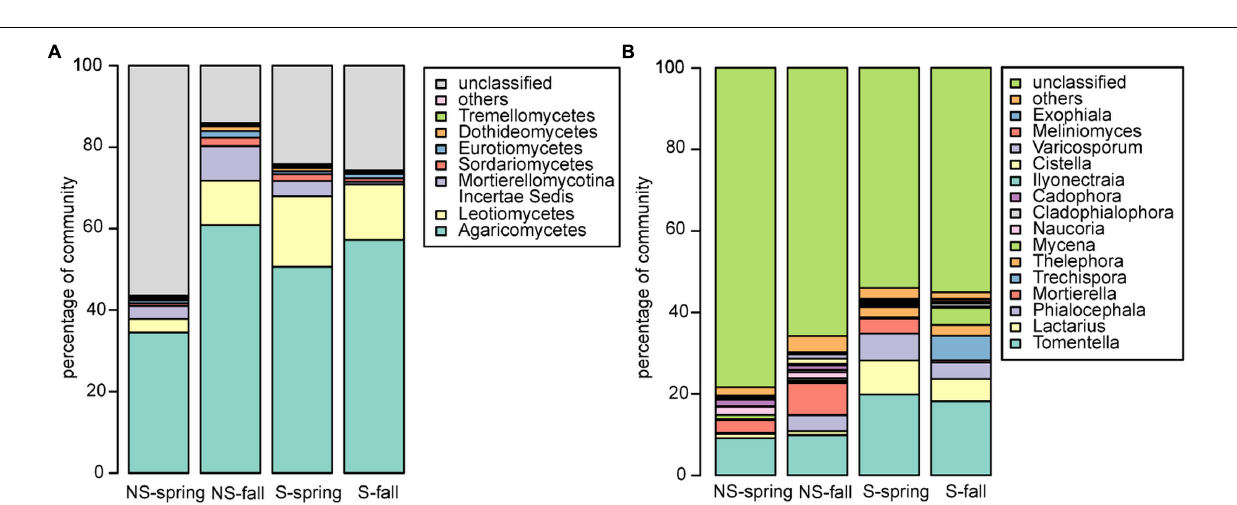
FIGURE 3 | Fungal community structure at the (A) class and (B) genus